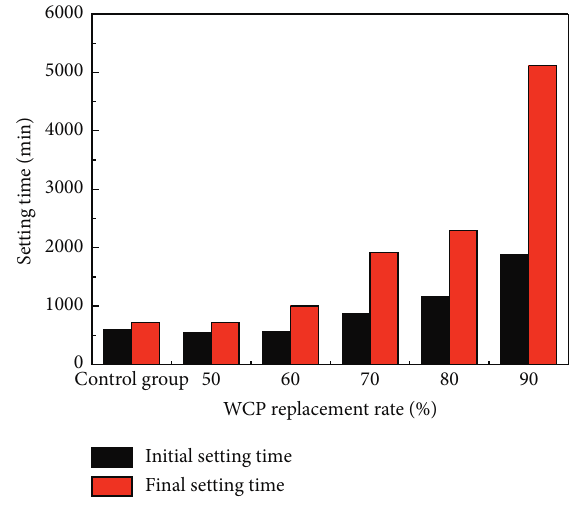
Figure 6: Setting time at different substitution rates.